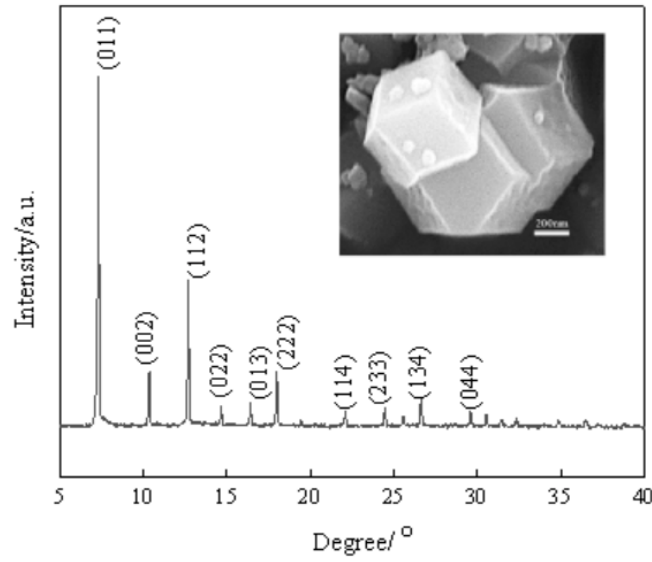
Figure 1. XRD pattern and SEM image of ZIF-67. Figure 1. XRD pa tt ern and SEM image of ZIF-67. Figure 1. XRD pa tt ern and SEM image of ZIF-67.